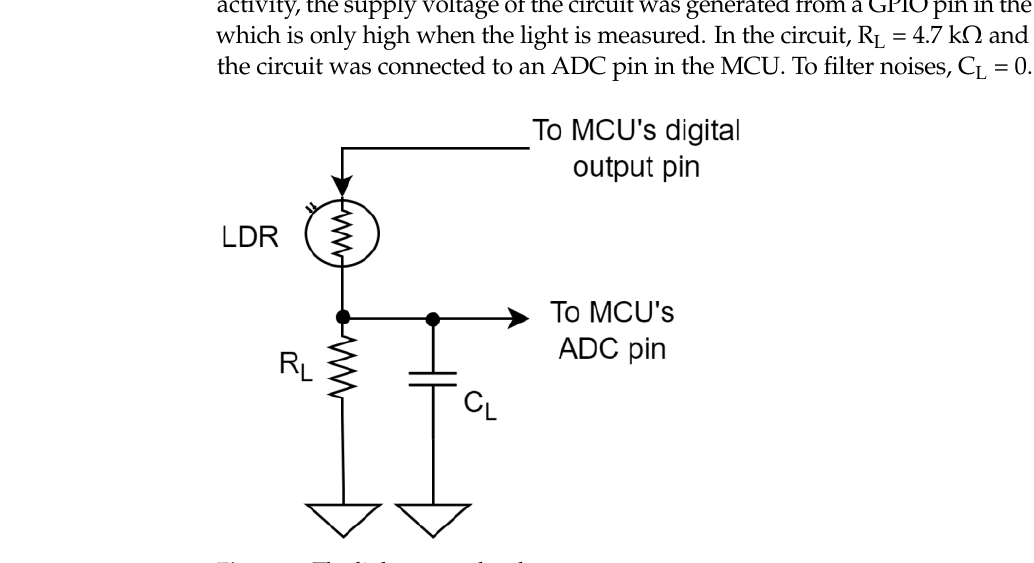
Figure 5. The light-sensor hardware.